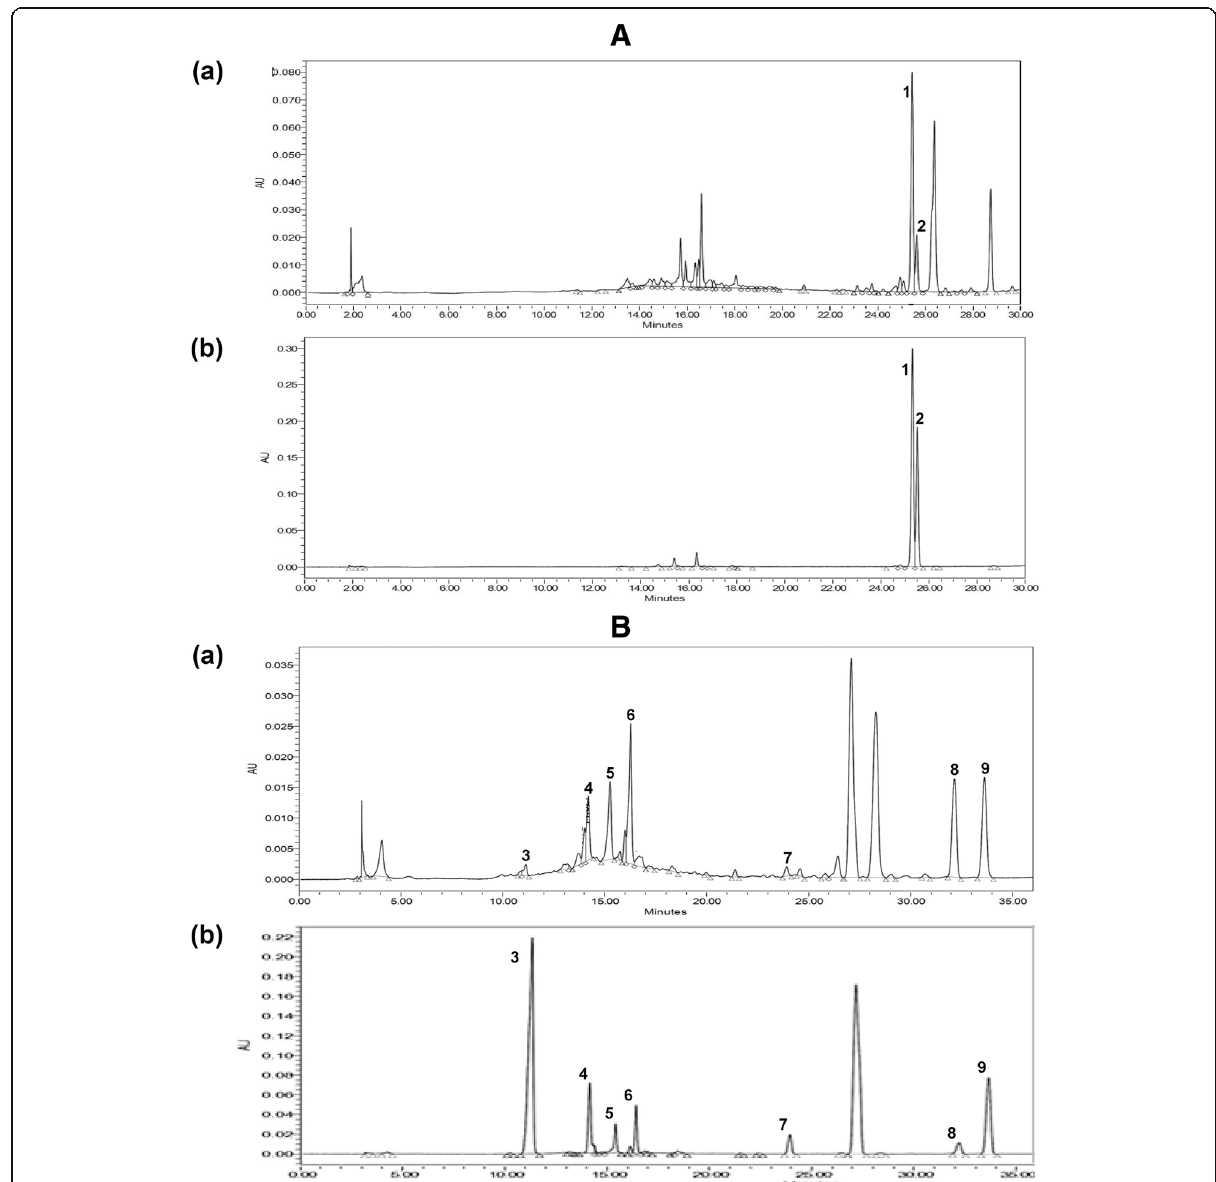
Fig. 1 HPLC analyses of 80% ethanol extract of Phyllanthus amarus . a Representative HPLC chromatograms of (a) 80% ethanol extract of Phyllanthus amarus (b) mixture of standards for identification and quantification of (1) phyllanthin (RT 25.354 min) and (2) hypophyllanthin (RT 25.547 min). b Representative HPLC chromatograms of (a) 80% ethanol extract of Phyllanthus amarus (b) mixture of standards for identification and quantification of (3) gallic acid at (RT 11.155 min), (4) geraniin at (RT 14.204 min), (5) corilagin at (RT 15.273 min), (6) ellagic acid at (RT 16.283 min), (7) niranthin at (RT 23.933), (8) phyltetralin at (RT 32.157), and (9) isolintetralin at (RT